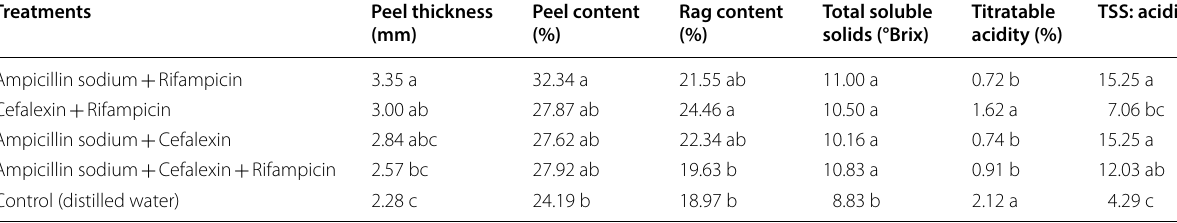
Means within a column with different letters are significantly different at P